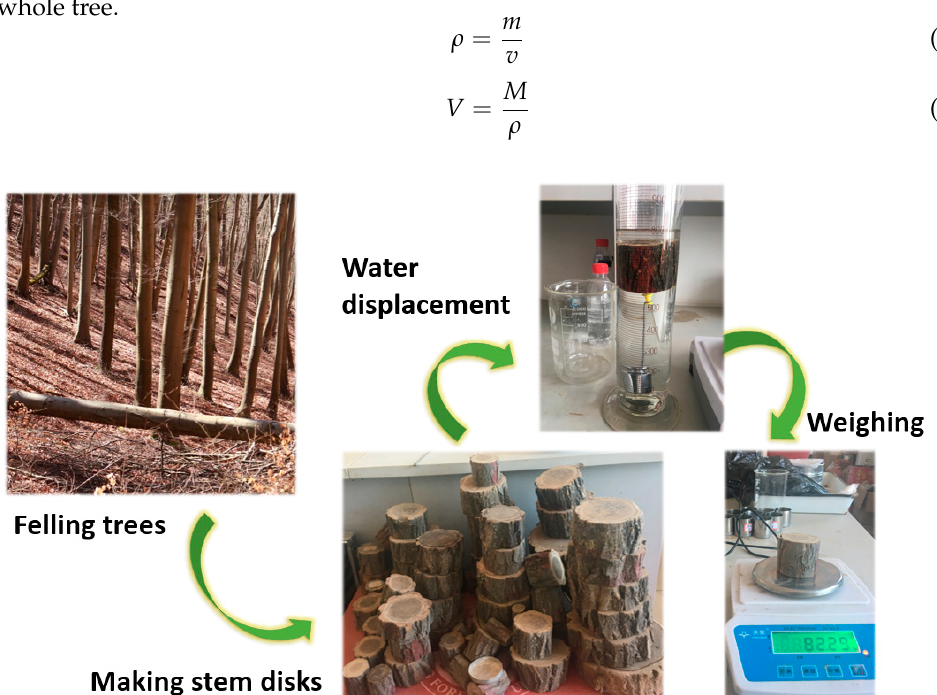
Figure A1. Water displacement method for stem volume and wood density (photography taken by Rui Shi and Baitian Wang).